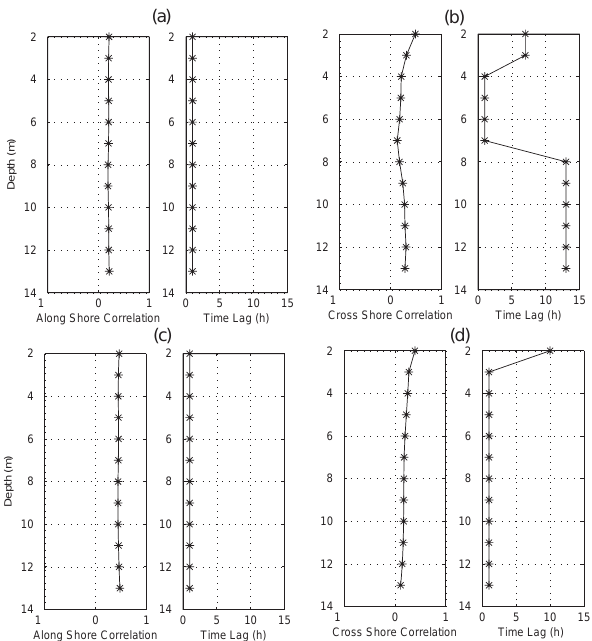
Fig. 5. Time-lagged correlations between wind speed ( U 10 ) and current velocity. The left-side graph in a pair is the correlation co- efficient ( r ), and the right-side graph is the time lag (h). (a) along- shore direction; (b) cross-shore direction; (c) low pass filtered wind and current in alongshore direction; (d) low pass filtered wind and current in cross-shore